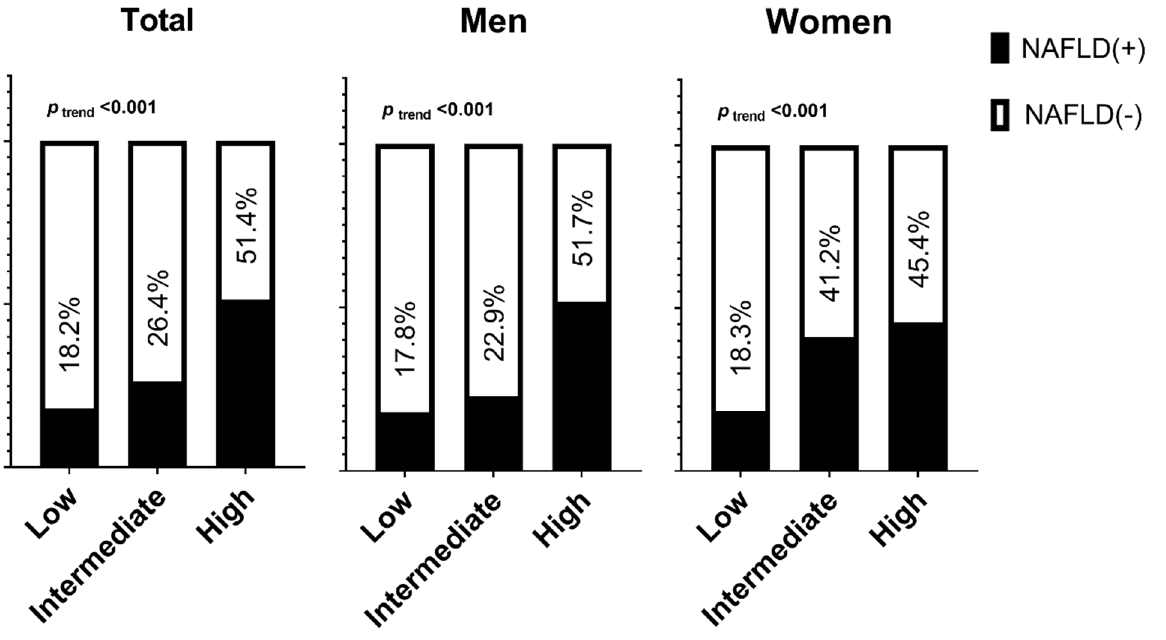
Figure 1. Prevalence of nonalcoholic fatty liver disease according to the risk of having obstructive sleep apnea by sex.